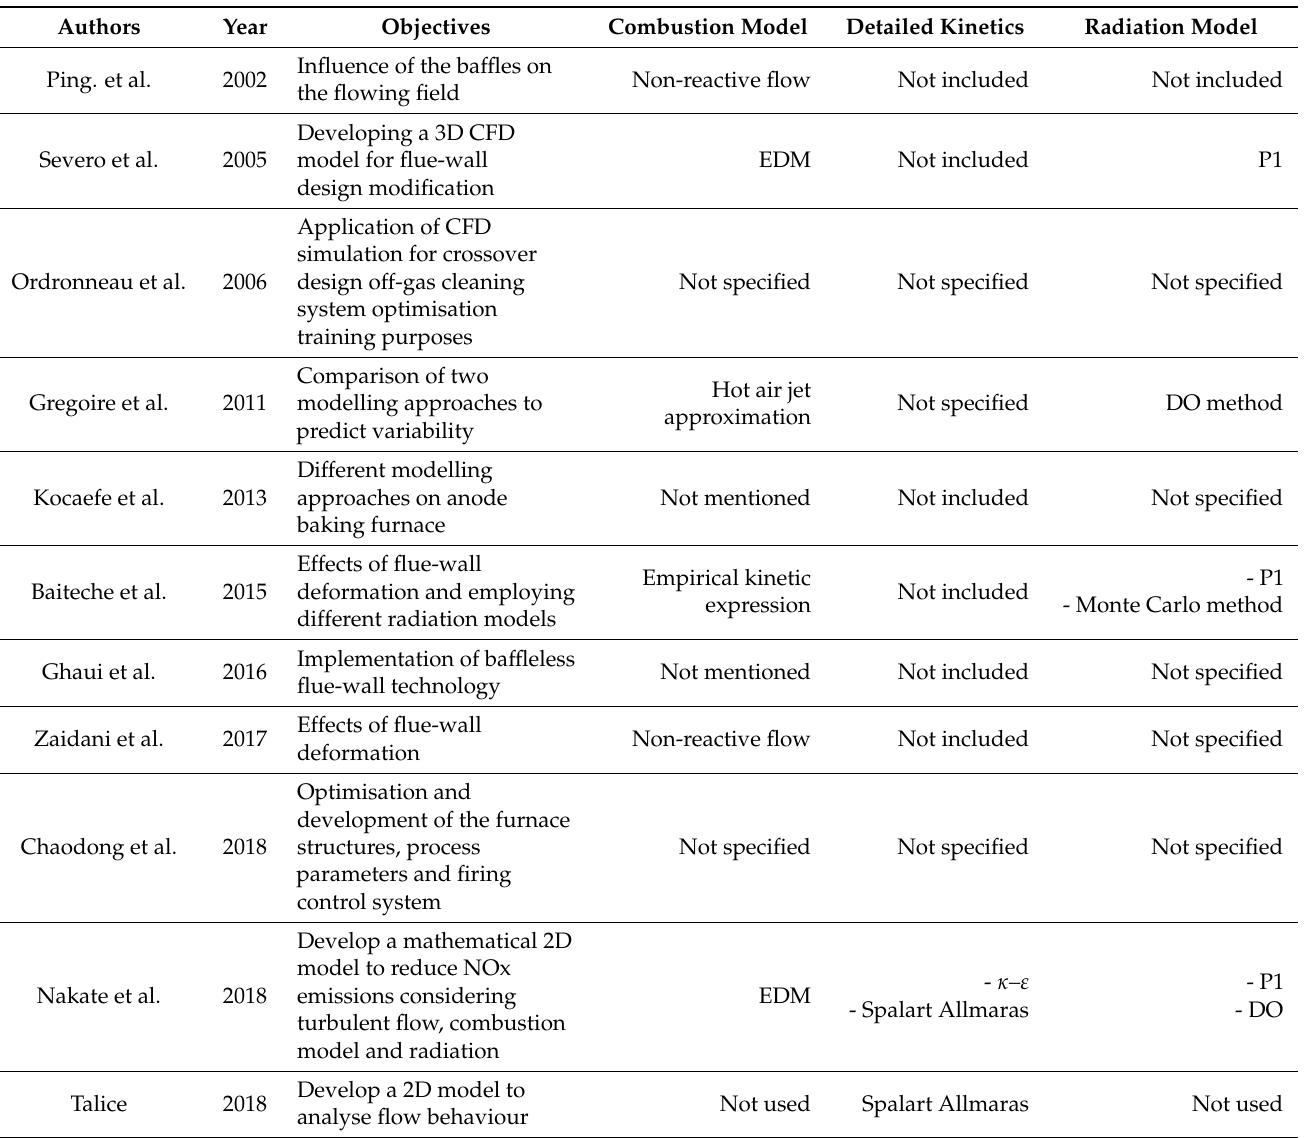
Table 1. Summary of literature review on ABF design